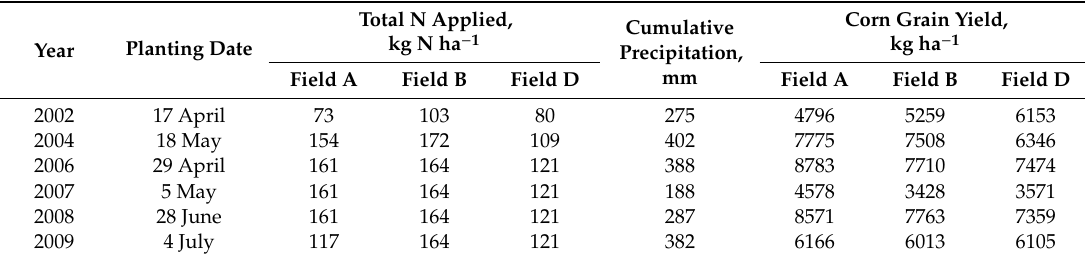
Table 1. Precipitation, applied nitrogen, and corn